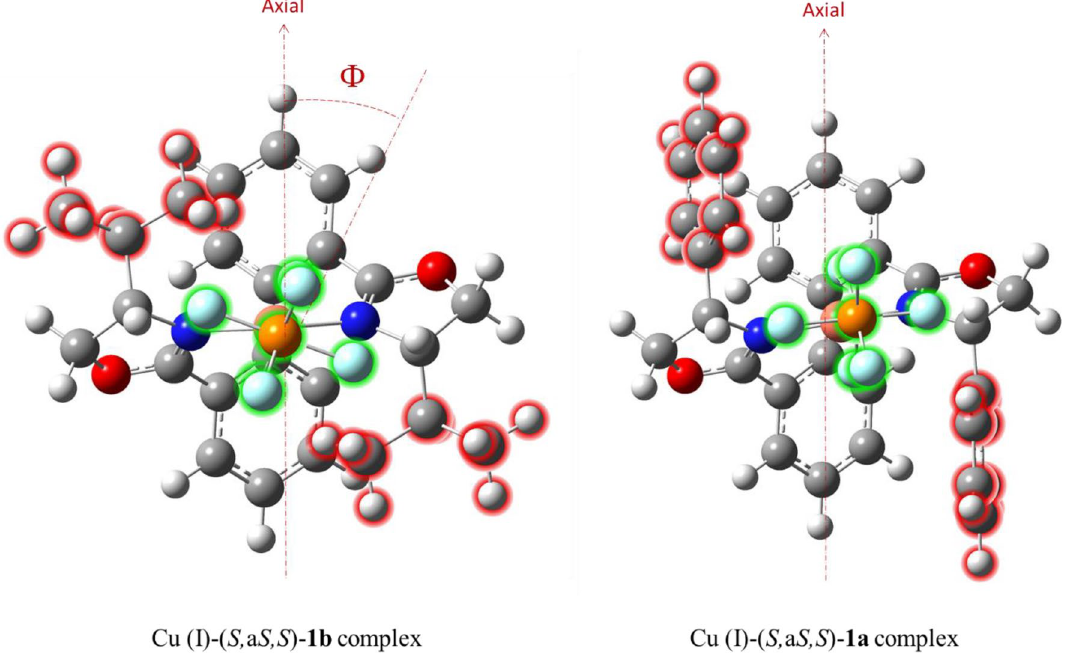
Figure 6. Steric repulsion caused by phenyl and iso propyl